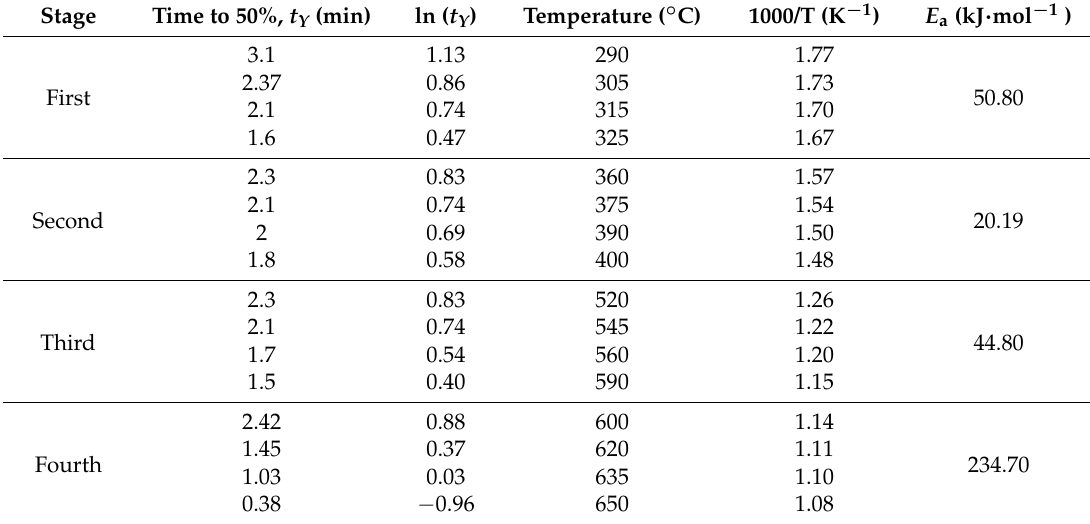
Table 3. Time taken to 50% of conversion ( Y = 0.5) from the data obtained in Figure 6. Stage